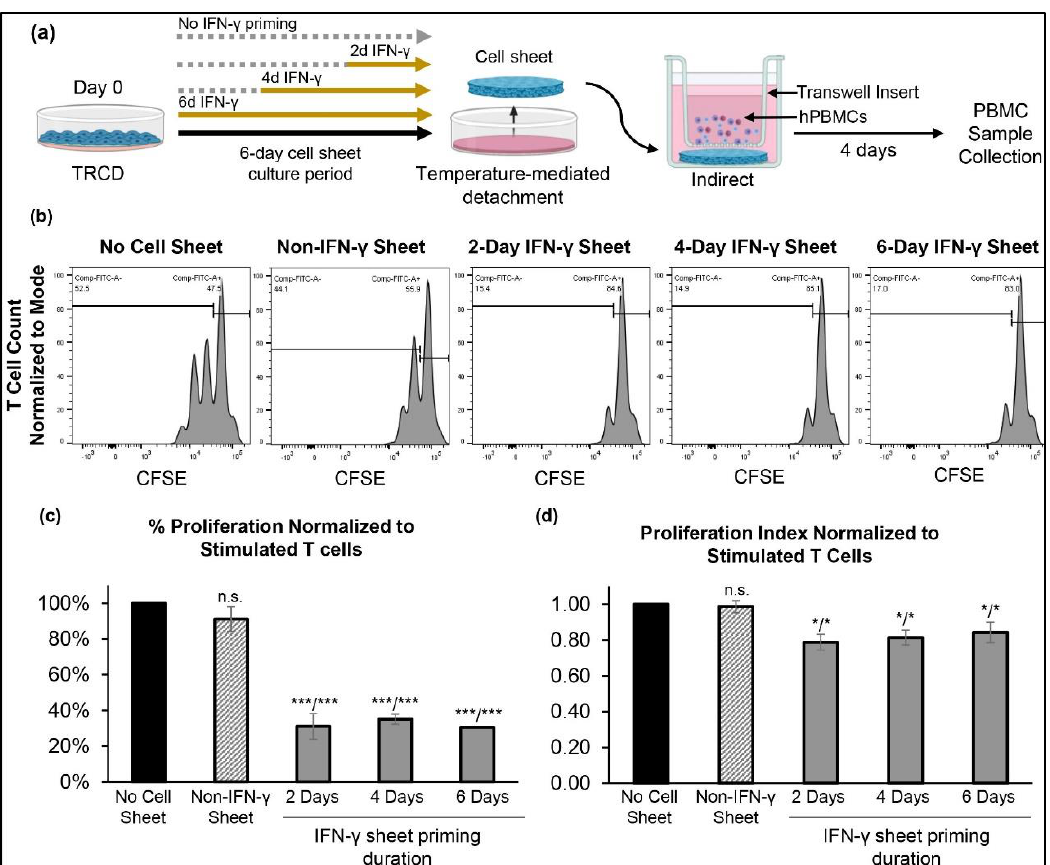
Figure 4. IFN- γ primed hcBMSC sheets exhibit enhanced immunosuppressive activity in indirect coculture with hPBMCs. ( a ) Experimental schematic of hcBMSC sheet fabrication and T cell proliferation coculture assay. ( b ) Representative flow cytometry plots of gated T cells − /+ hcBMSC sheet indirect coculture. Quantification of ( c ) percent proliferated T cells (divided cells) and ( d ) proliferation index normalized to stimulated T cells in PBMC control, no coculture, group. Error bars represent means ± SD ( n = 3, independent experiments) (n.s. p ≥ 0.05, * p < 0.05, *** p < 0.001). Statistical analysis p values are represented as compared to no cell sheet/non-IFN- γ sheet.